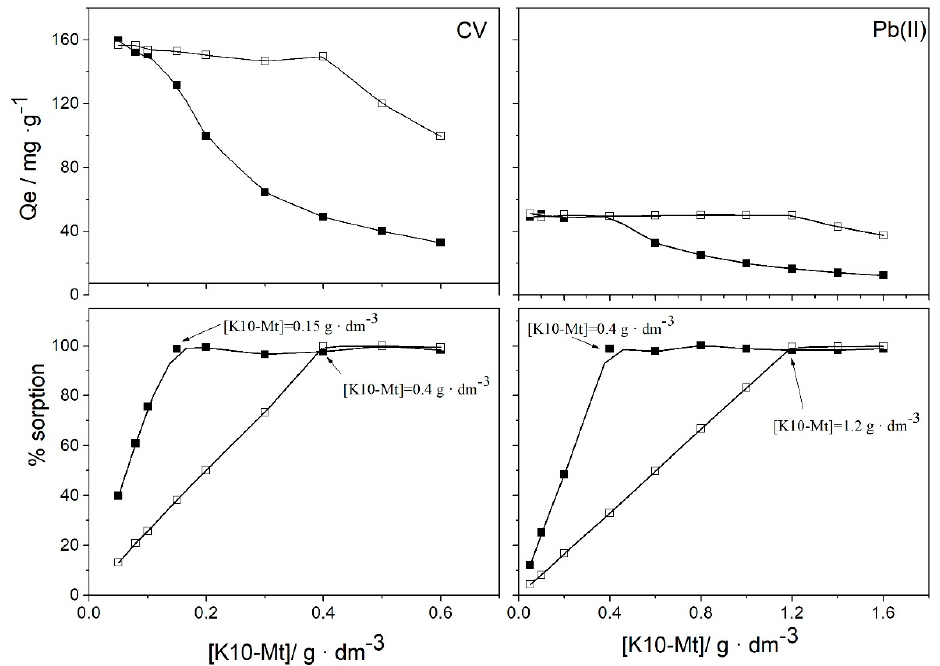
Figure 1. Sorption capacity of pollutants as a function of the amount of clay at pH 2.0. C 0 = 20 mg·dm − 3 ( ■ ) and C 0 = 60 mg·dm − 3 ( □ ). The amount of clay required for the complete adsorption of contaminants is indicated by the arrows in the graph.